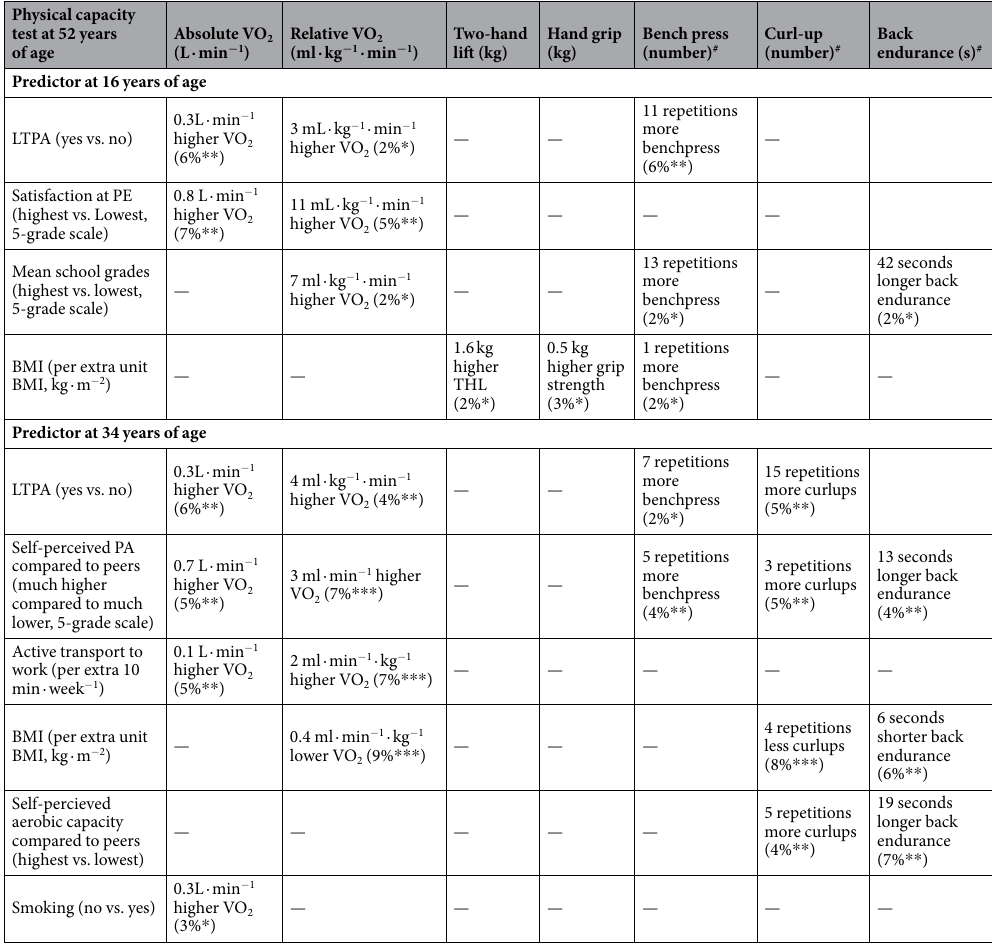
Table 3. Predictors at 16 or 34 years of age for the physical fitness at 52 years of age. Each predictor was tested individually in a regression analysis after adjustment for gender and height 2 . The variance that each predictor explains is presented in brackets. * p < 0,05, ** p < 0,01, *** p < 0,001, [—] indicates that there was no significant association betweenthe variables. # Analyses were performed on square-root transformed numbers, however, the numbers presented for the effect of predictor are derived from analyses of non-transformed numbers. y = years of age, THL = two-hand lift, PE = physical education, LTPA = Leisure-time physically active. Height 2 at 52 years of age and gender were included as independent factors in all models (see Methods, Statistical analysis). The exception was relative VO 2 max where height 2 was not